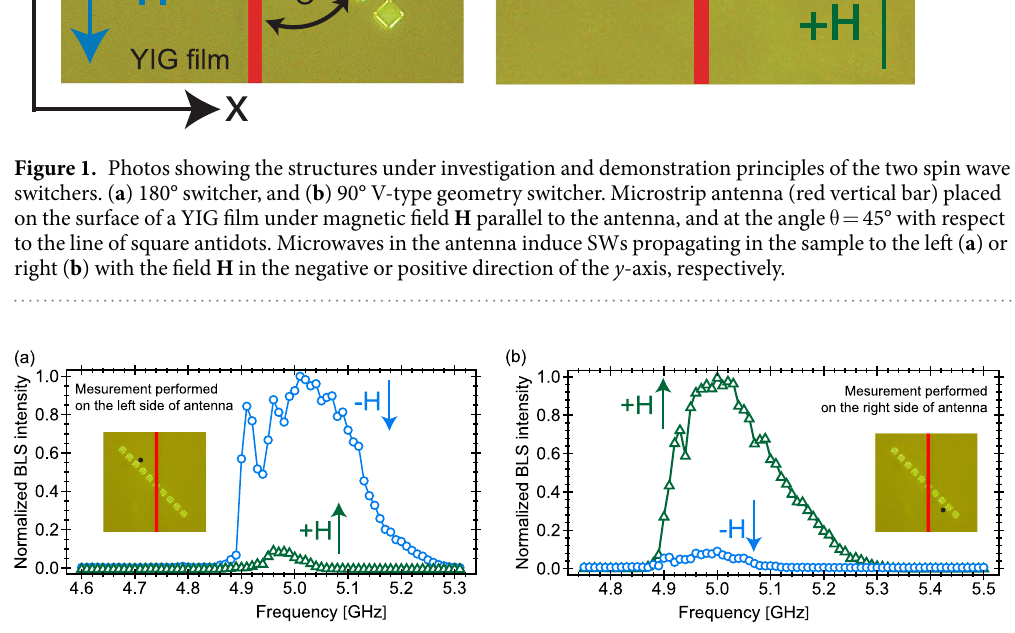
Figure 2. Experimental demonstration of the switching of spin waves with change of the magnetic field orientation. Normalized BLS intensity spectrum as a function of frequency, measured on the left ( a ) and right ( b ) of the microwave antenna for a laser light spot (black dot in the insets) near the right and left side of the antidots, with two magnetic field orientations, + H and − H , respectively, at H = 980